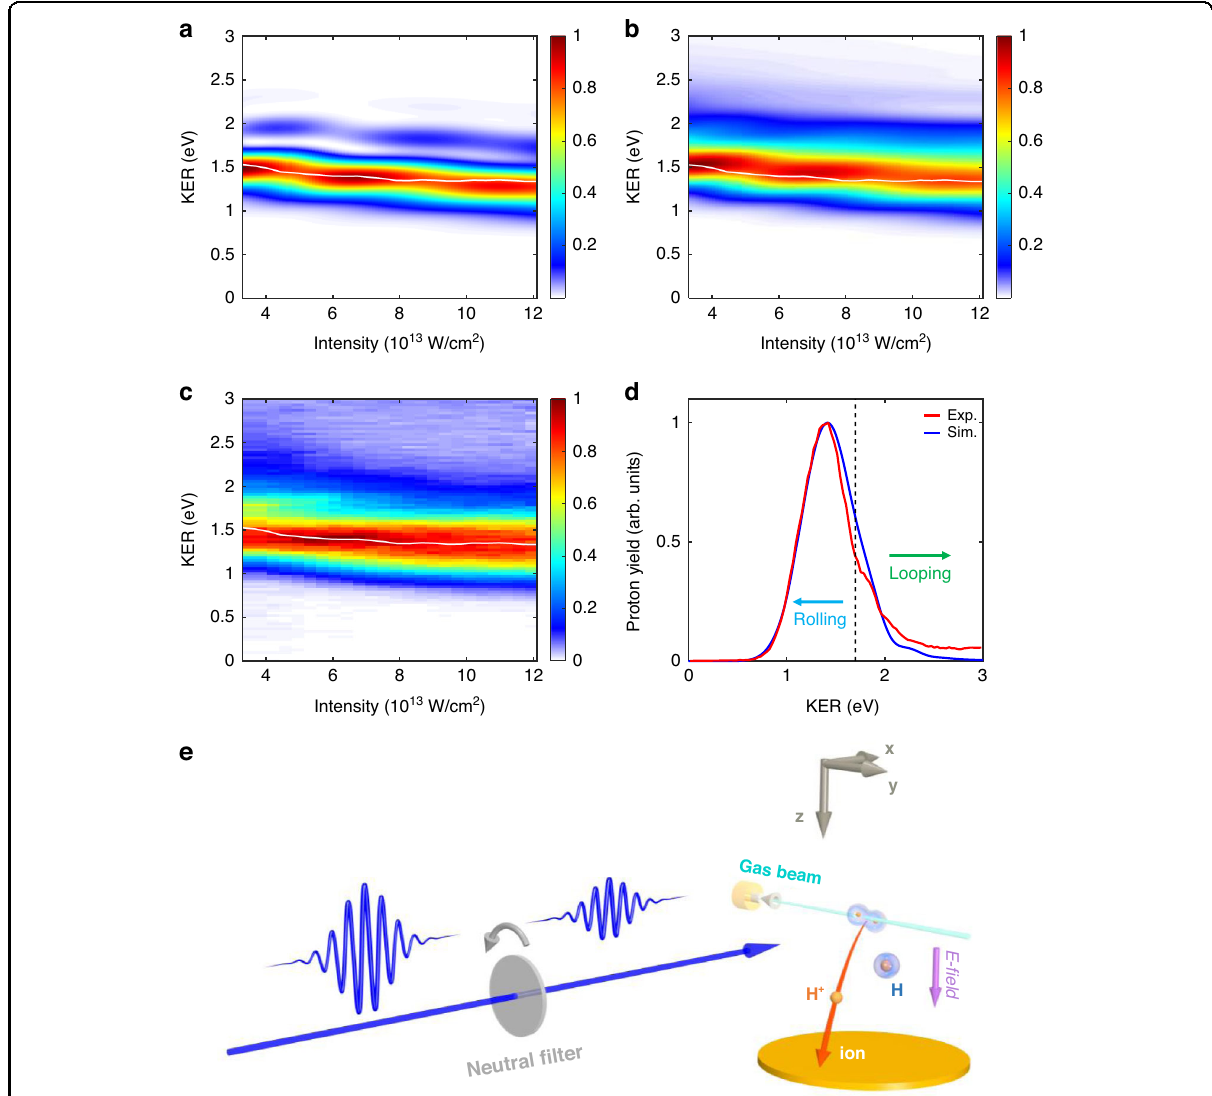
Fig. 4 Probing rolling and looping dynamics via comparing experiments with simulations. a The simulated KER spectra as a function of the peak intensity of a ten-optical-cycle 400-nm laser pulse. The initial state is the superimposed vibrational state weighted by Frank-Condon factors, which freely propagates 6 fs before the laser pulse acts. b Same as ( a ) but averaged over free propagation time of 2,10 fs of the initial state. c The experimentally measured KER spectra at different laser intensities. The white curves in ( a – c ) illustrate the mean values of the KER spectra at different laser intensities. d The asymmetric KER spectra obtained by integrating the signals in ( b ) and ( c ) over all laser intensities. The low- and high-energy regions partitioned by the black dashed line are labeled as rolling and looping pathways. The maxima of all the spectra are normalized to one for the convenience of comparison. e Schematic illustration of the experimental